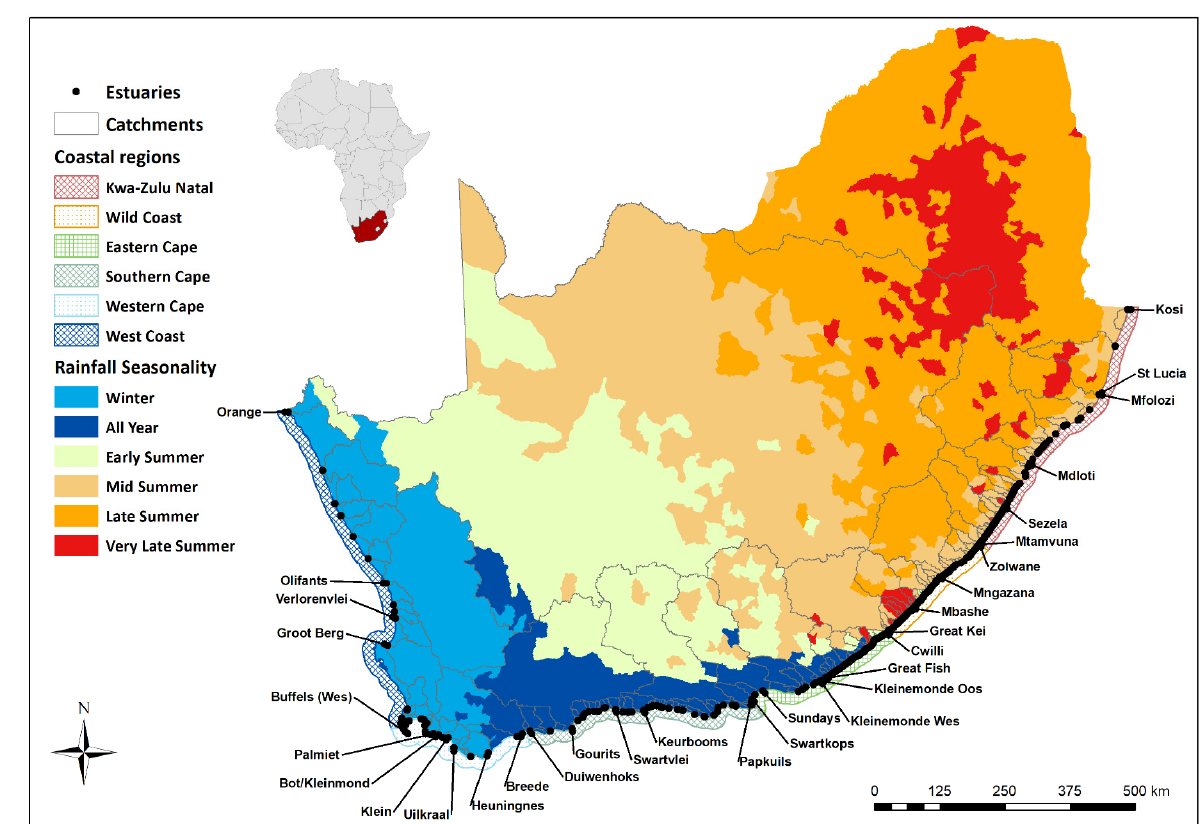
Figure 1. Map showing the seven coastal regions, relative catchment size, and rainfall seasonality for South Africa.